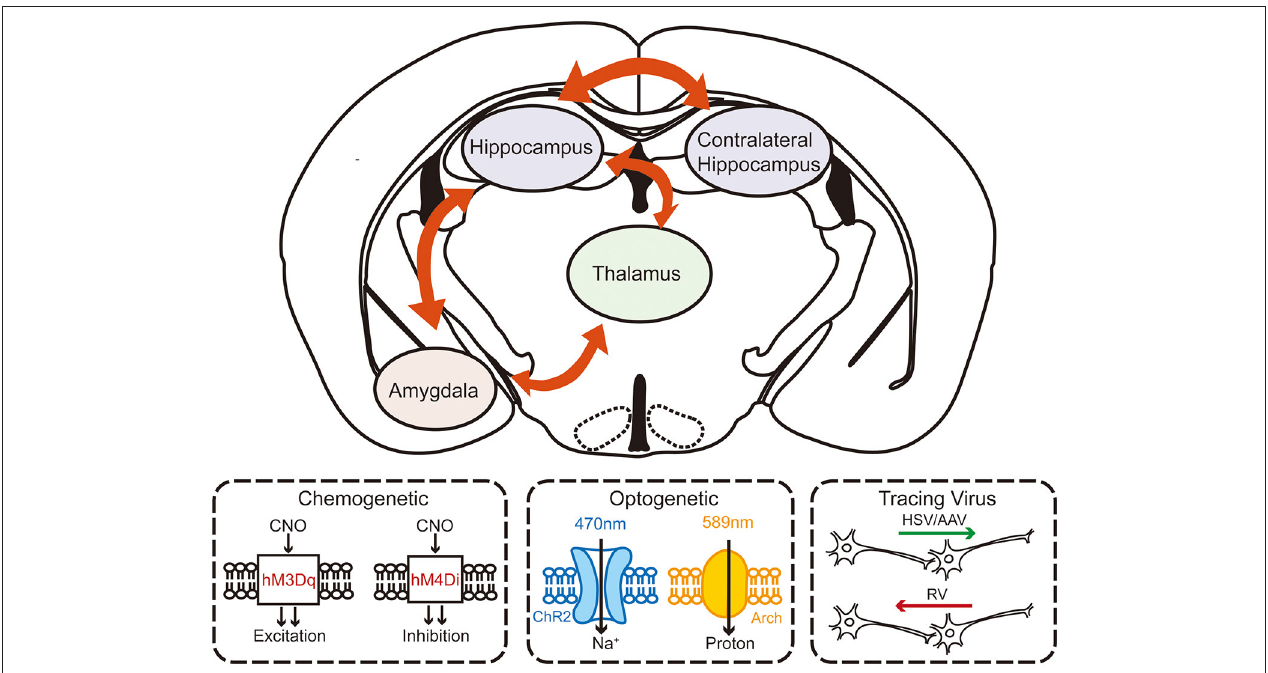
FIGURE 2 | The schematic diagram of investigating the circuity mechanism of secondary epileptogenesis in temporal lobe epilepsy by using advanced experimental approaches. Combined multifaceted techniques including chemogenetics, optogenetics, and viral tracing can help to reveal the possible circuitry basis of secondary